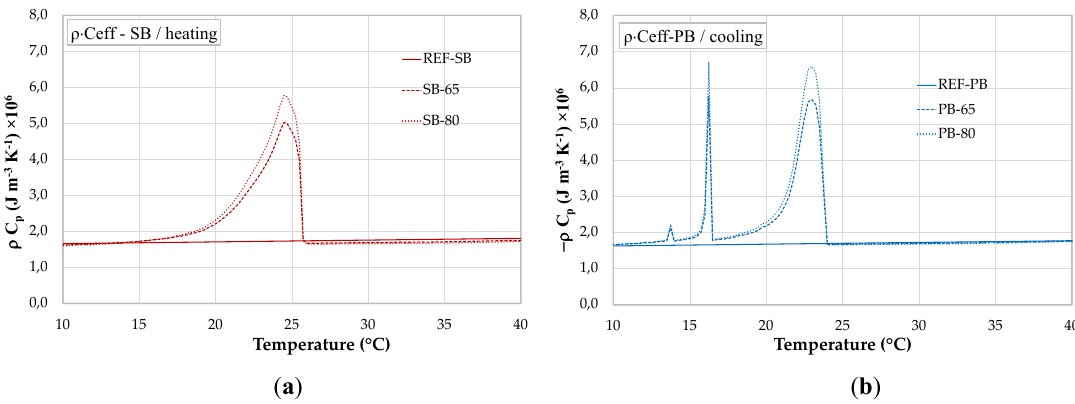
Figure 8. ρ × Ce ff of PCM-RBA mortar systems with PB bricks: ( a ) heating and ( b ) cooling.